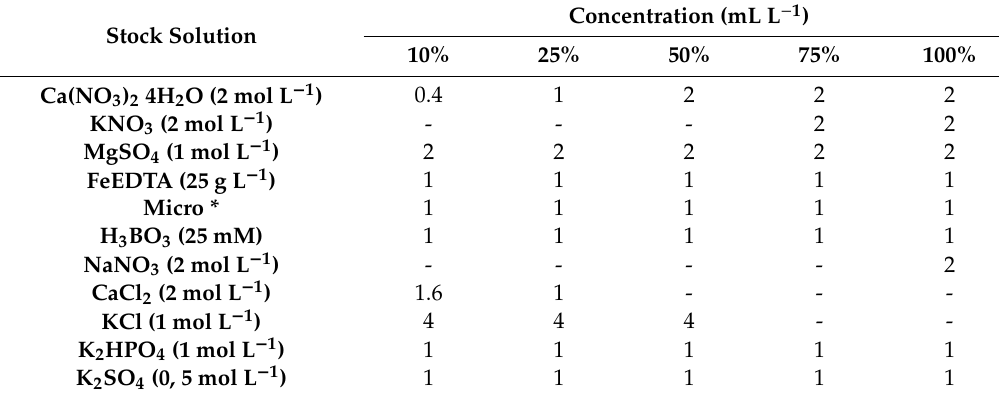
Table 7. Solution with five di ff erent contrasting N levels, based on the Hoagland and Arnon Solution,